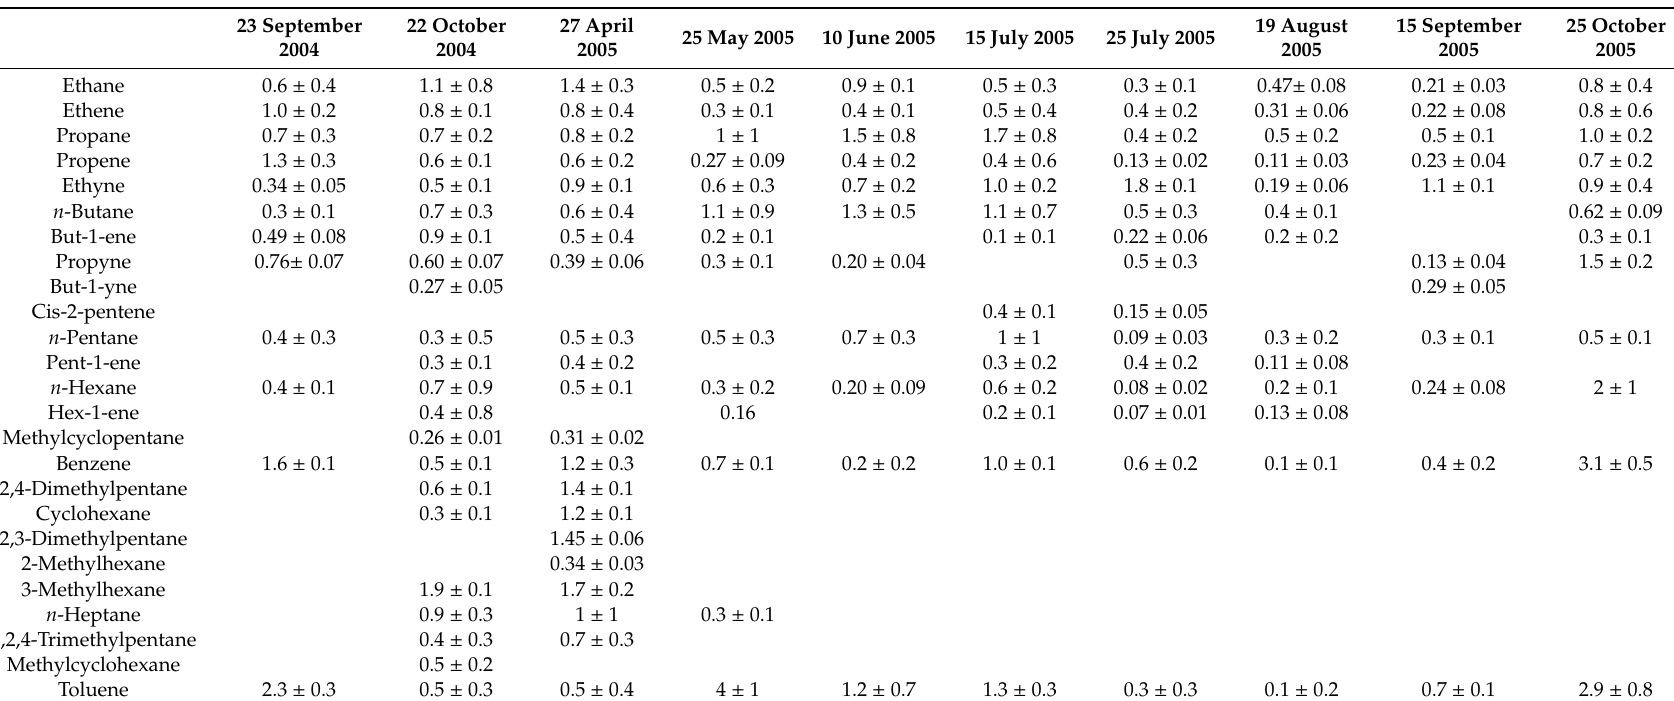
Table 1. Detected compounds in ambient air samples and their daily average mass concentration ( µ g m − 3